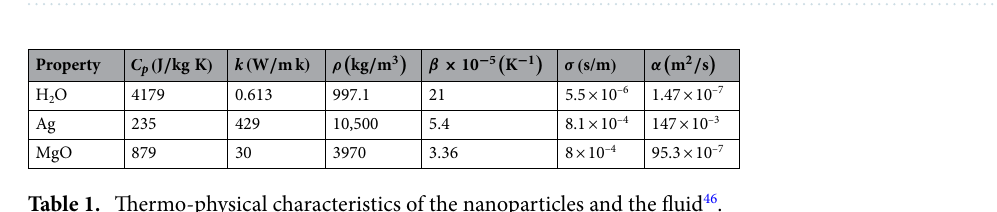
Figure 1. Boundary conditions and mesh of the studied model.